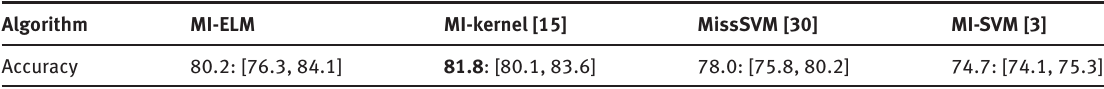
Table 5: Test Accuracy on COREL. Algorithm